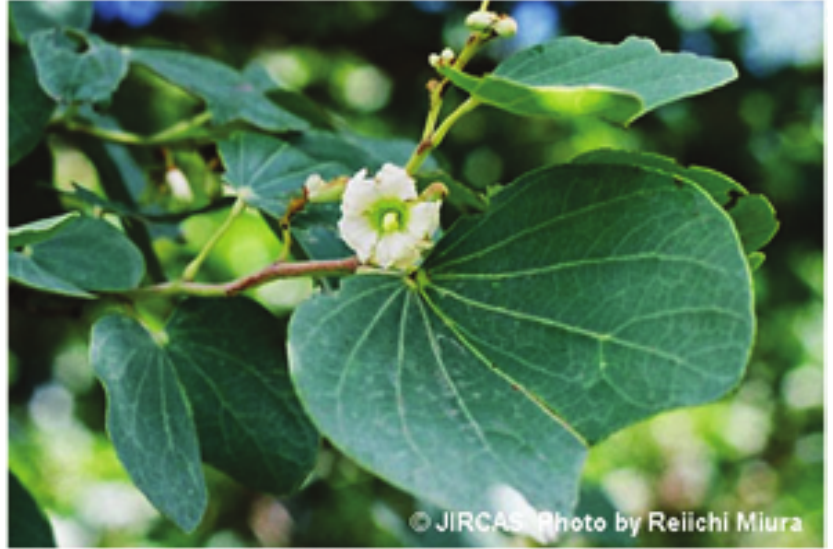
Figure 2: Leaves and flowers of P.